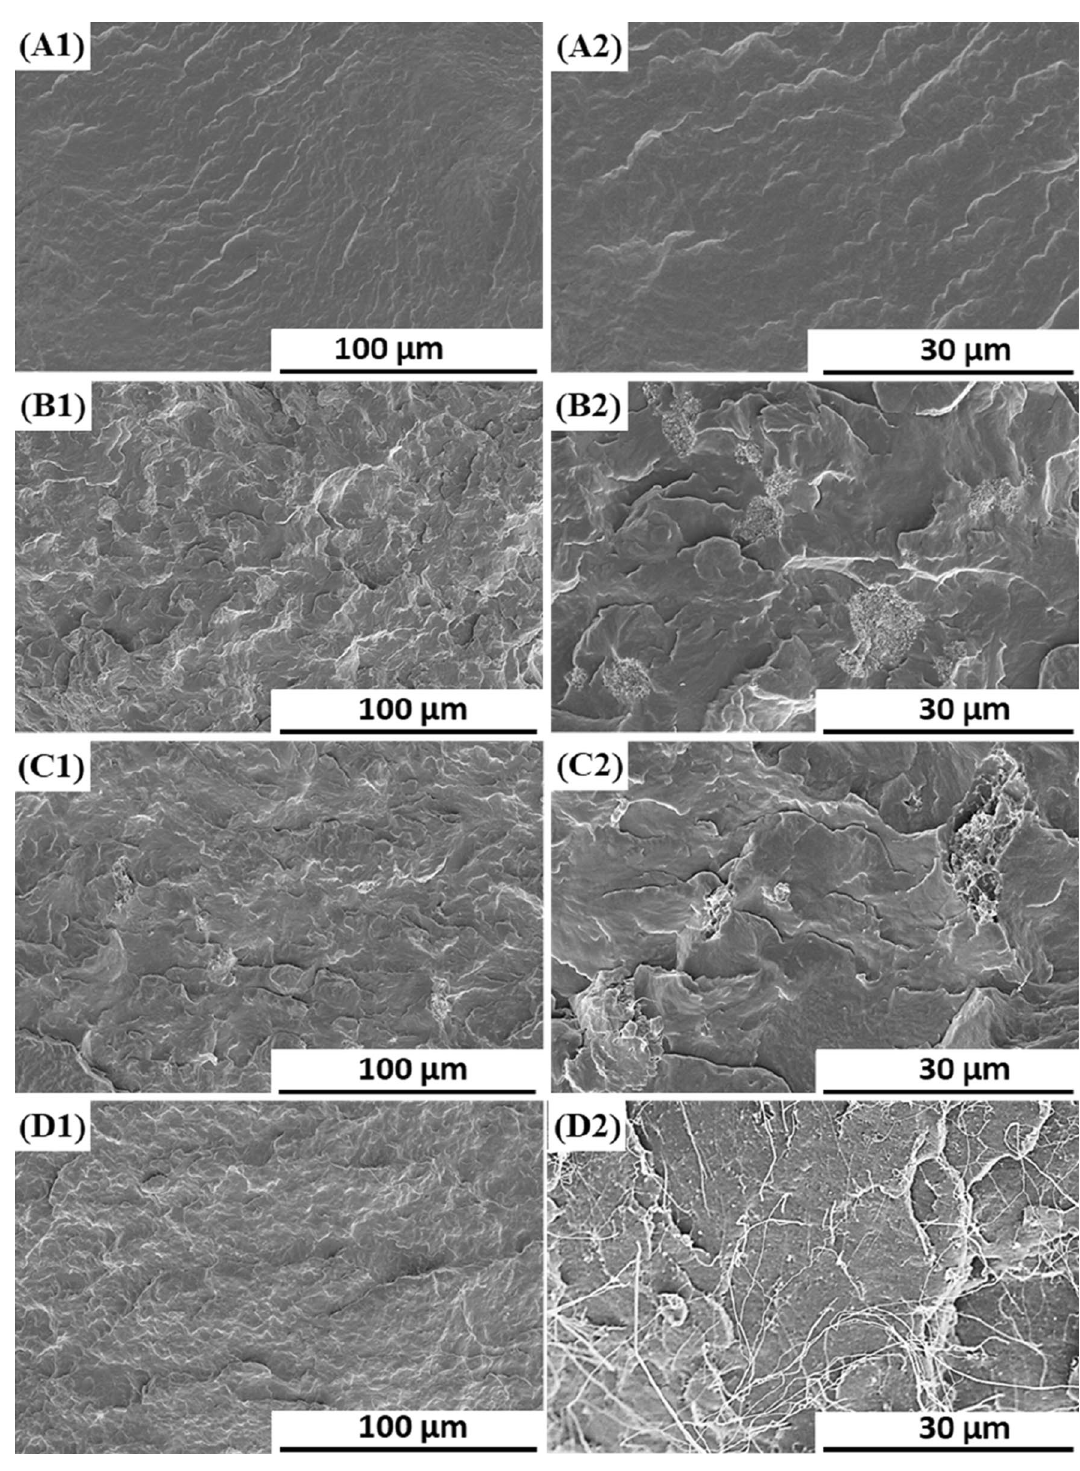
Figure 4. SEM micrographs of the fractured surface of PBS and PBS/PTFE: ( A ) PBS ( B ) PBS/P5 ( C ) PBS/P220 ( D )